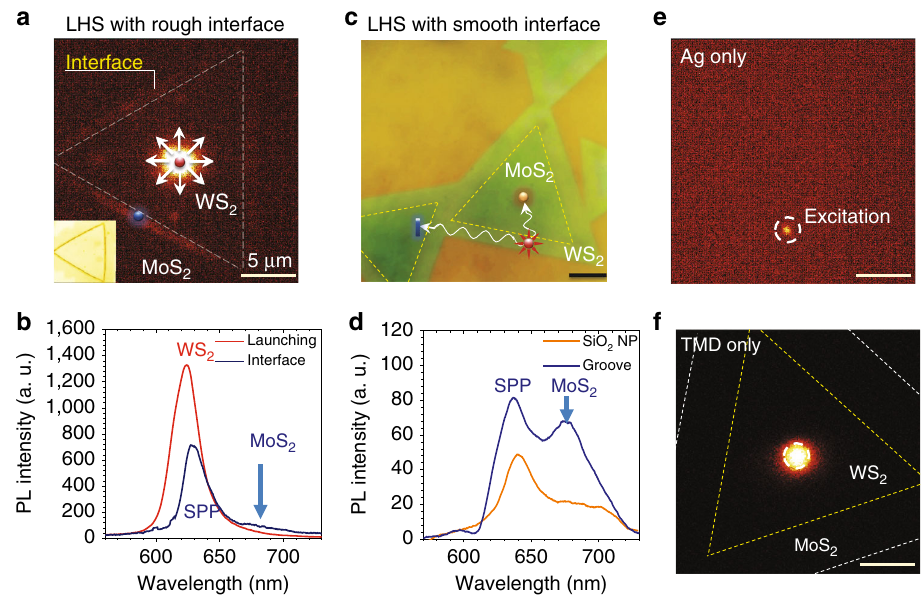
Fig. 2 Experimental demonstration of SPP-assisted exciton energy transfer in a WS 2 /MoS 2 TMD LHS. a PL spatial mapping from a metal-oxide- semiconductor (MOS) structure in which the LHS has rough interfaces. Excitons in WS 2 (indicated by the red dot ) created in the centre of the inner triangle are converted to SPPs, which propagate isotropically and are out-coupled at the interface, exciting the excitons from the MoS 2 region (indicated by the blue dot ). b PL spectra collected at the launching site and at the interface of the LHS shown in a . c An optical microscopy image of monolayer thick MoS 2 / WS 2 LHS with atomically sharp interfaces. The laser excitation site (indicated by the red star ), the out-coupling sites at a SiO 2 nanosphere (indicated by the orange dot ), and a groove on the Ag plate (indicated by the blue slit ) are labeled on the image. d The spectra taken at the out-coupling sites of the nanosphere and the groove, respectively. e , f The PL spatial mapping images obtained from an Ag plate alone e , and from a TMD LHS on a Si/SiO 2 substrate f . The scale bars in all fi gures correspond to 5 µ m